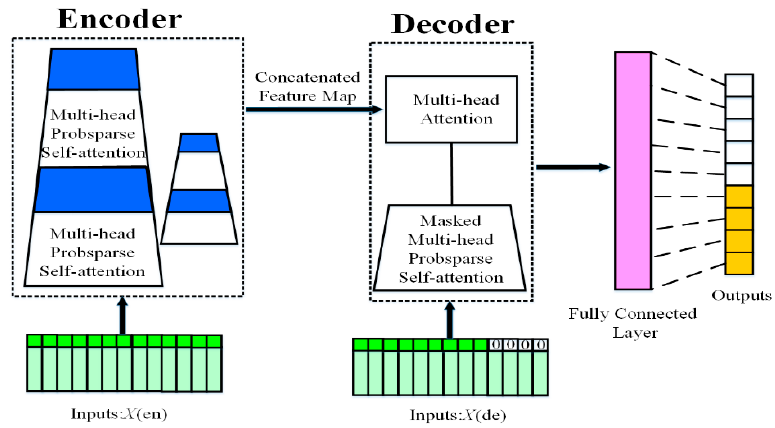
Figure 5. The structure of the D-P-Transformer rockburst prediction algorithm.